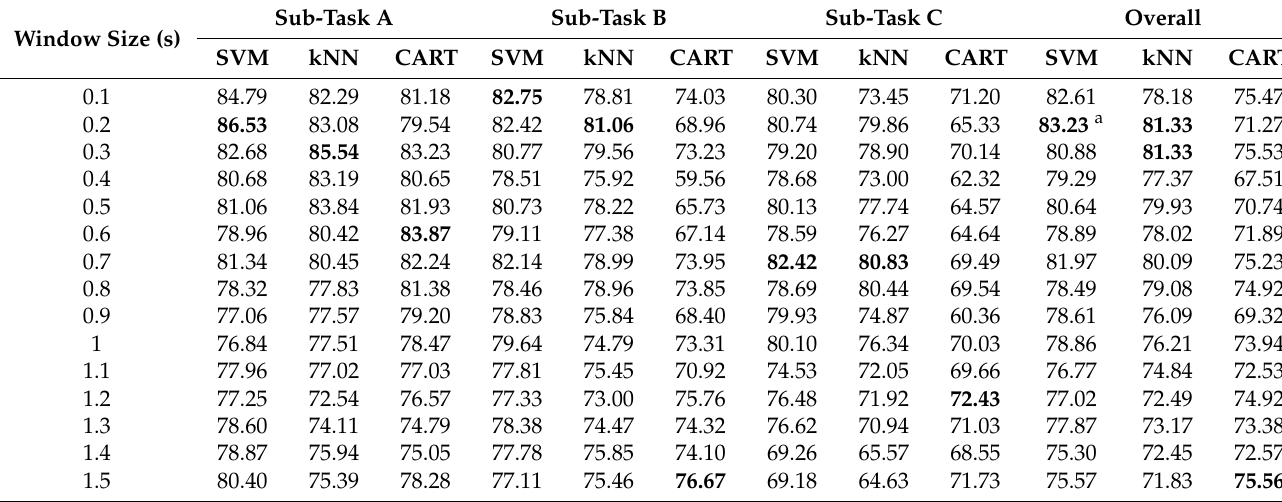
Table 7. The F-score of the sub-task segmentation using machine learning approaches (%) vs. different window sizes (s). Sub-Task A Sub-Task B Window Size (s)